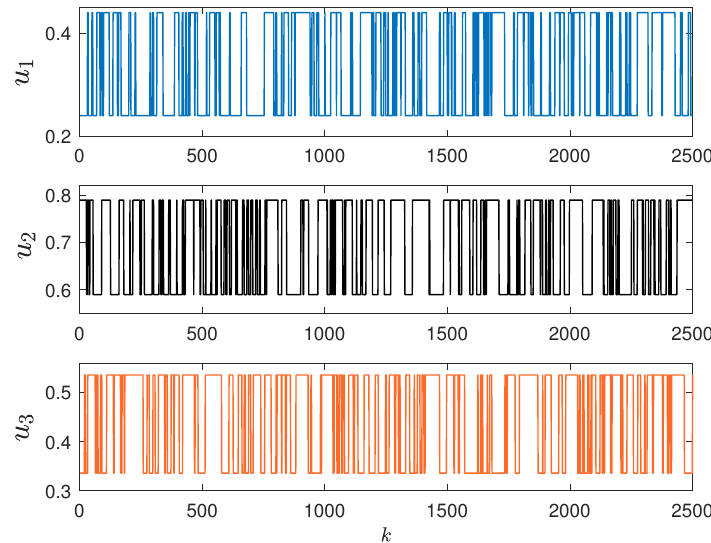
Figure 4. GBN signals utilized in the identification